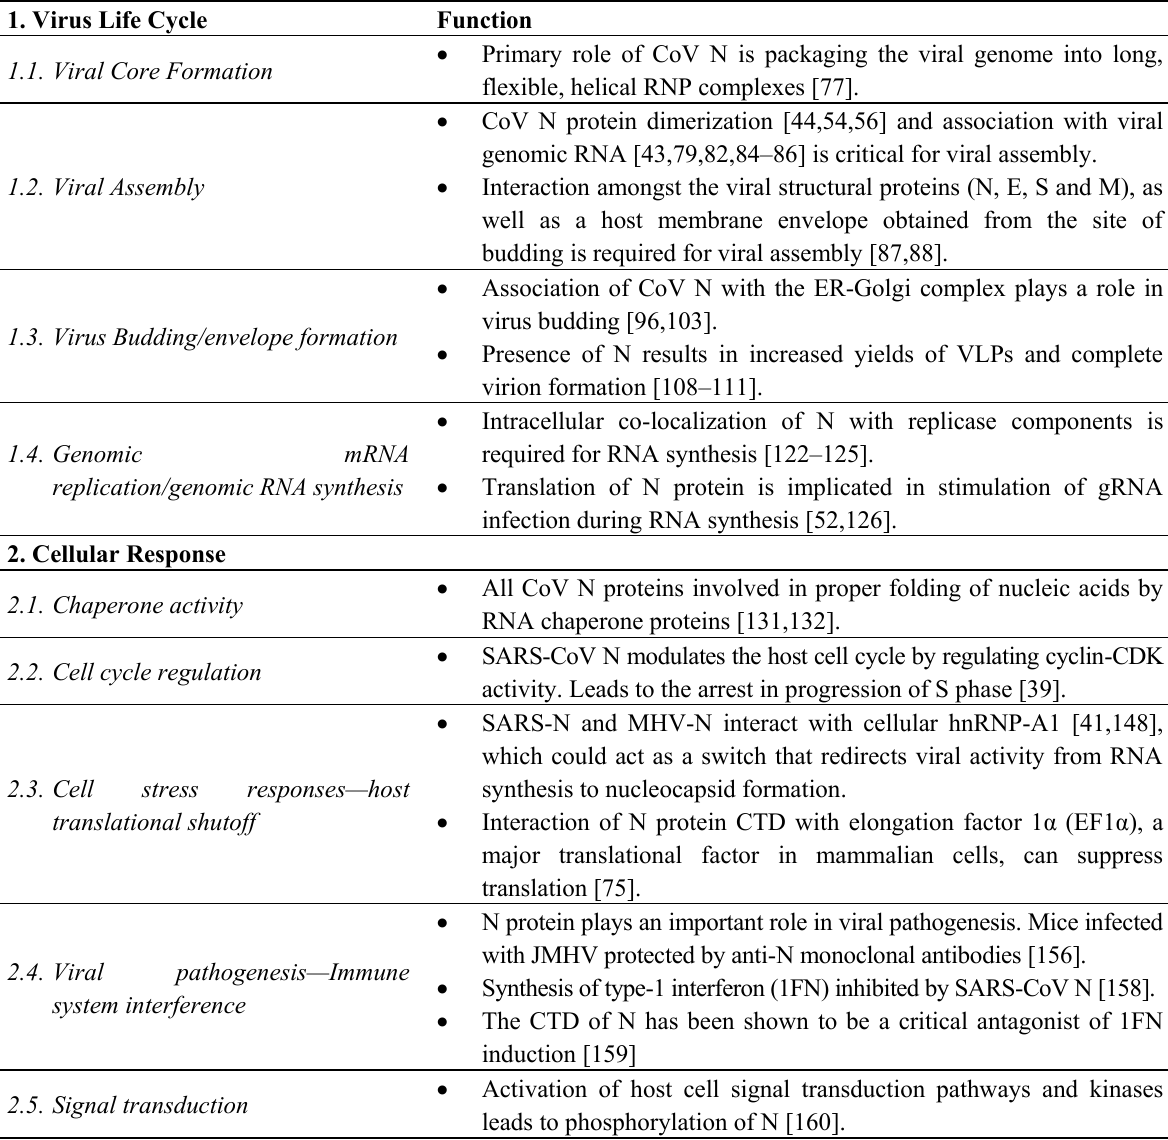
Table 1. Summary of the role of coronavirus N protein in the (1) virus life cycle and (2) cellular